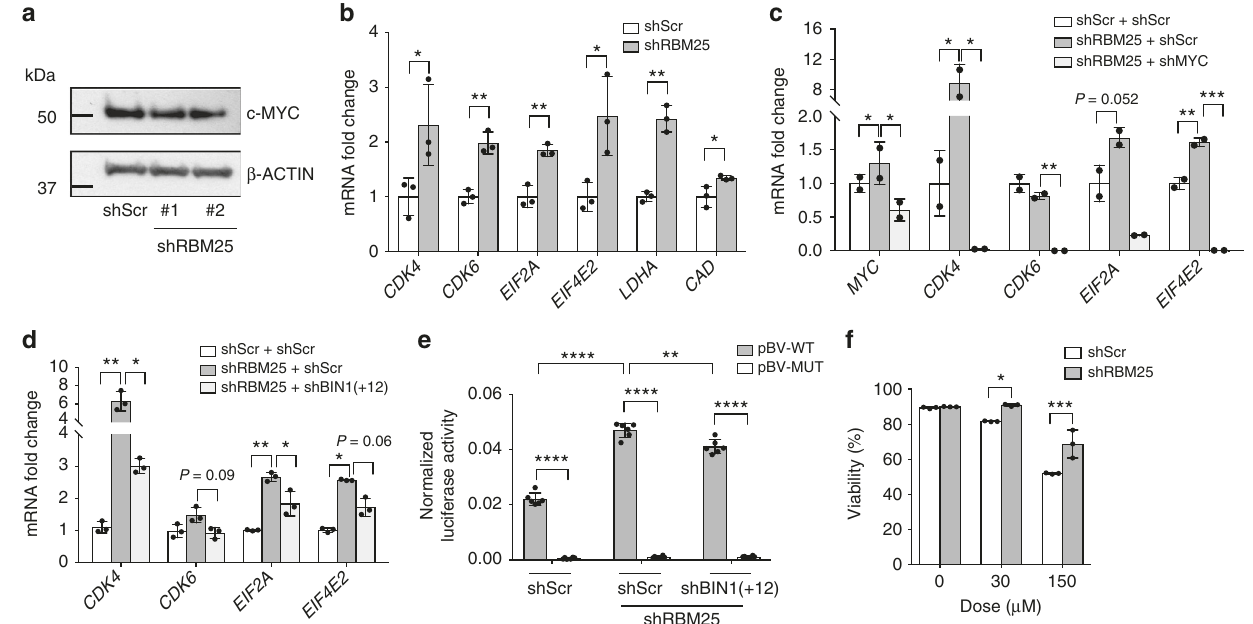
Fig. 7 RBM25 restricts MYC activity through inhibition of the expression of the BIN1( + 12) isoform. a Western blot of MYC expression in U937 cells transduced with the indicated shRNAs. b − d The expression of MYC target genes as assayed by qPCR in U937 cells after b RBM25 KD, c double KD of RBM25 and MYC (data represent the mean ± s.d., n = 2, P values were calculated using a one-way ANOVA test), and d double KD of RBM25 and the BIN1 ( + 12) isoform (data represent the mean ± s.d., n = 3). e Dual luciferase reporter assay demonstrating the effect of RBM25 KD on a reporter construct containing either WT (pBV-WT) or mutated (pBV-MUT) MYC binding sites with and without simultaneous KD of the BIN1( + 12) isoform (data represent the mean ± s.d., n = 6). f Effect of the MYC inhibitor 10058-F4 on the viability of U937 cells with or without RBM25 KD (data represent the mean ± s.d., n = 3). Data were subjected to an unpaired t test, and asterisks indicate the following: * P < 0.05, ** P < 0.01 *** P < 0.001, **** P < 0.0001. All panels